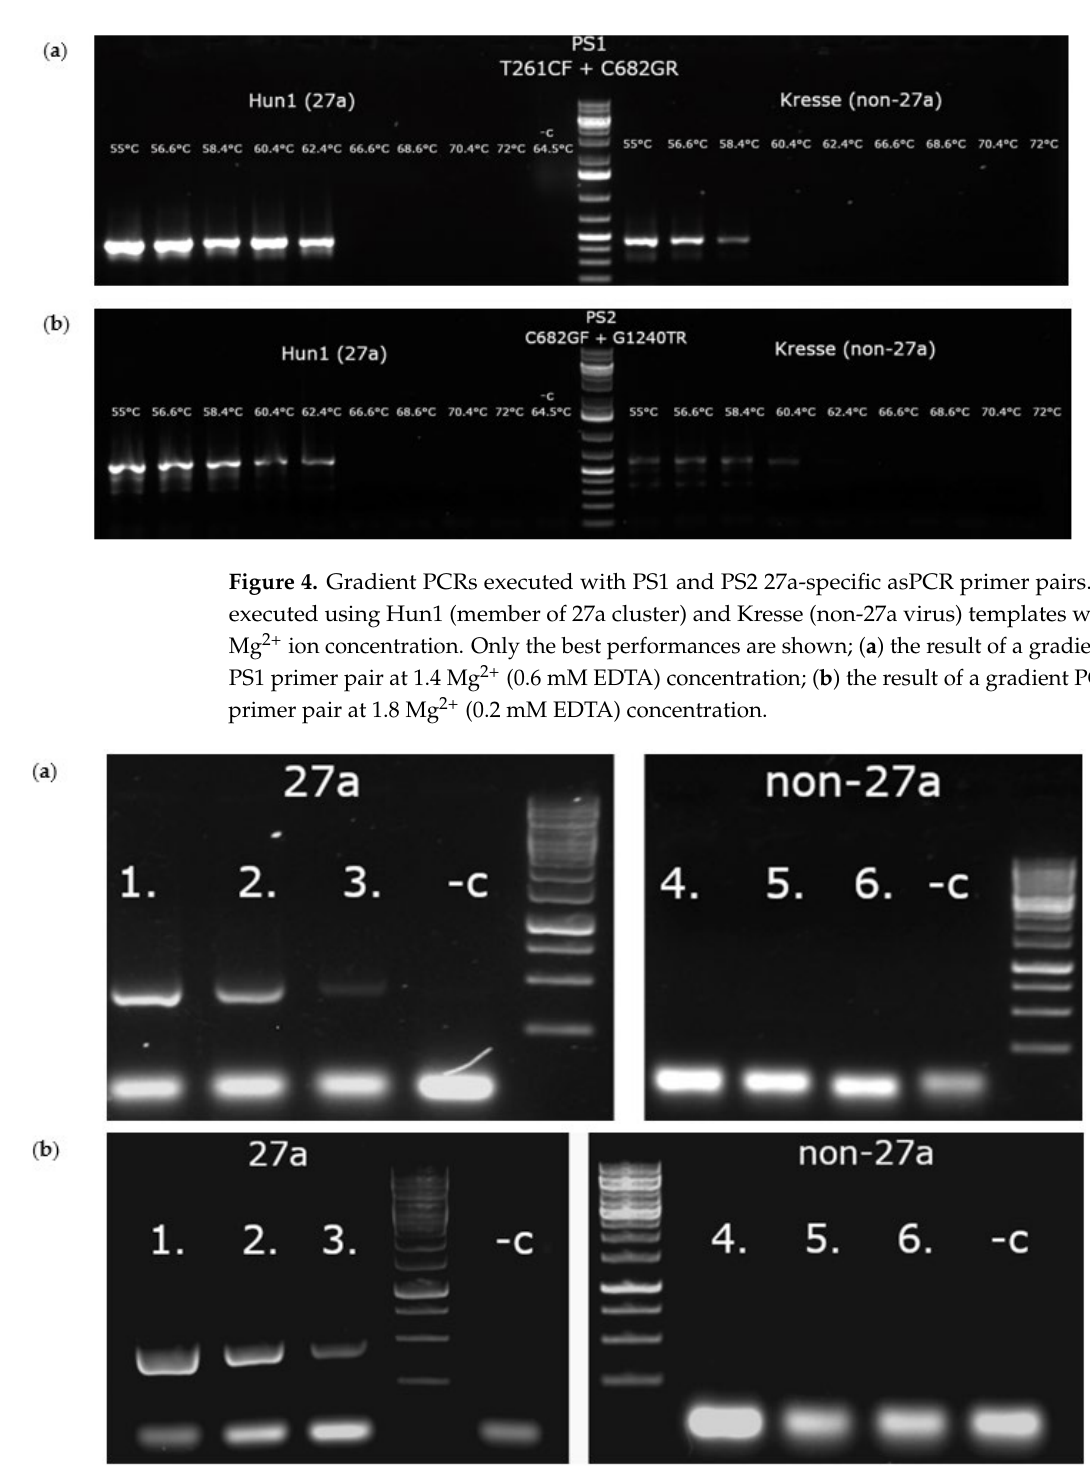
Figure 5. Efficiency of DreamTaq ( a ) and DreamTaq Hot Start ( b ) enzymes on different 27a and non- 27a templates. Numbers 1–3 are three different 27a samples; 4–6 are three different non-27a samples; -c is negative control; markers are GeneRuler 1 kb DNA ladders.